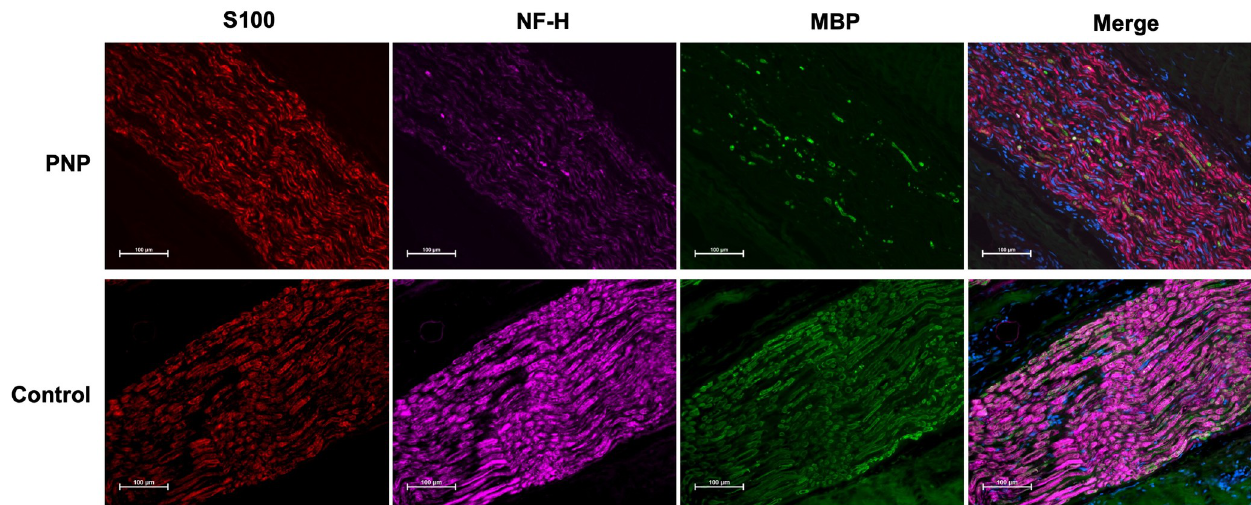
Fig 3. Immunofluorescent staining. S100 positive Schwann cells (red), neurofilament-H (NF-H; purple) and myelin basic protein (MBP; green) are reduced in polyneuropathy (PNP). In the merged panel, cell bodies are counter-stained with DAPI (blue). Imaged at 20x magnification under equal exposure times; scale bar: 100 μ m.